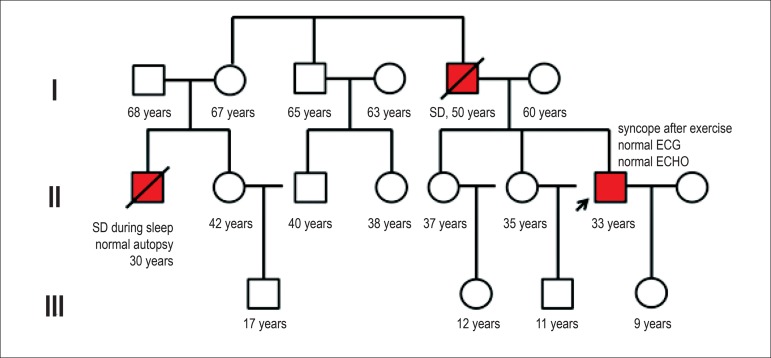
Pedigree chart of a family with clinical suspicion of channelopathy.
Square: man; circle: woman; oblique bar: deceased; arrow:
index-case; red circle or square: affected individual; SD: sudden
death; ECHO: echocardiography.